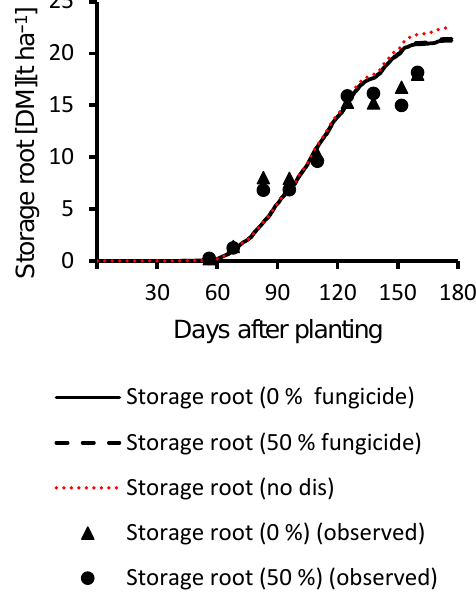
Figure 8. Simulated and observed values (2016): storage root weight (DM t ha − 1 ) for the evaluation treatments with (0% fungicide, 50% fungicide) and without (‘no dis”) Cercospora leaf spot ratings included in the simulation.